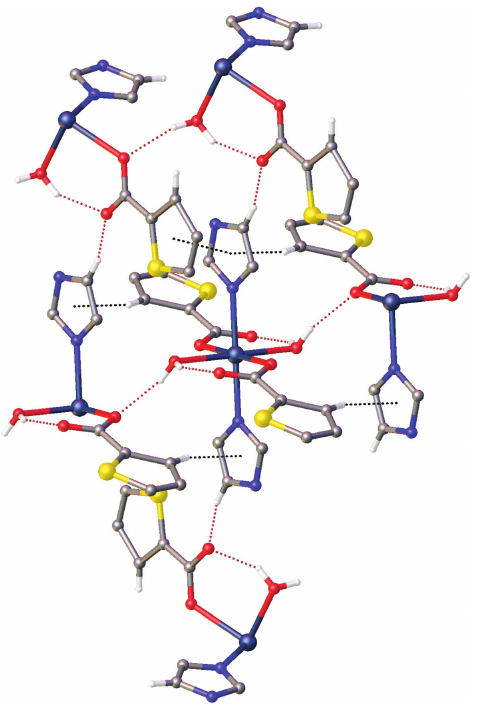
Figure 2 The O-H···O, C-H···O, C-H··· π and π ··· π interactions in the Mn and Cd complexes.